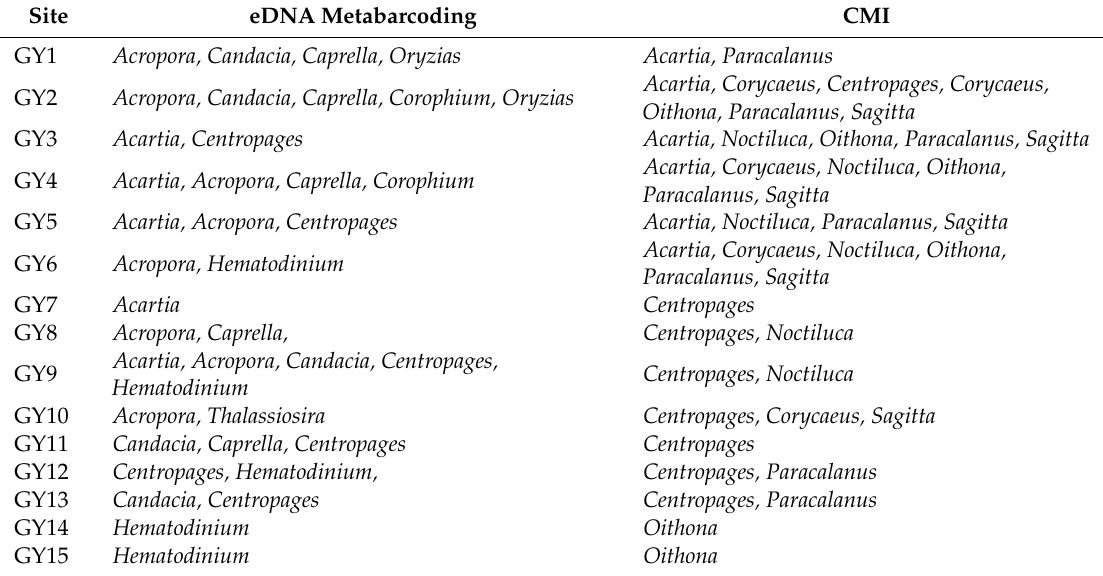
Table 2. Dominant plankton groups observed during the summer season (June and September) in Gwangyang